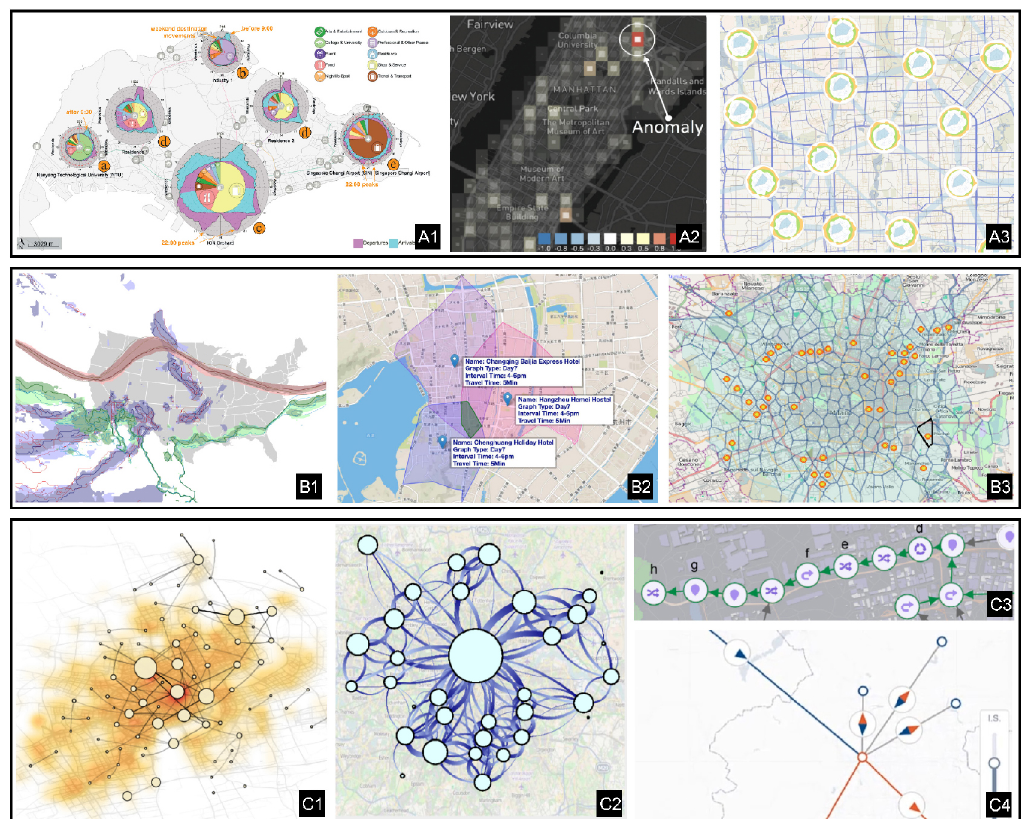
Fig. 2 (A) Examples of glyph-on-the-map visualization. (B) Examples of area-on-the-map visualization. (C) Examples of graph-on-the-map visualization. Reproduced with permission from Ref. [45] for (A1), c (cid:13) IEEE 2017; Ref. [103] for (A2), c (cid:13) IEEE 2018; Ref. [69] for (A3), c (cid:13) IEEE 2021; Ref. [92] for (B1), c (cid:13) IEEE 2016; Ref. [48] for (B2), c (cid:13) IEEE 2020; Ref. [26] for (B3), c (cid:13) IEEE 2010; Ref. [18] for (C1), c (cid:13) IEEE 2011; Ref. [27] for (C2), c (cid:13) IEEE 2016; Ref. [116] for (C3), c (cid:13) The Author(s) 2020.